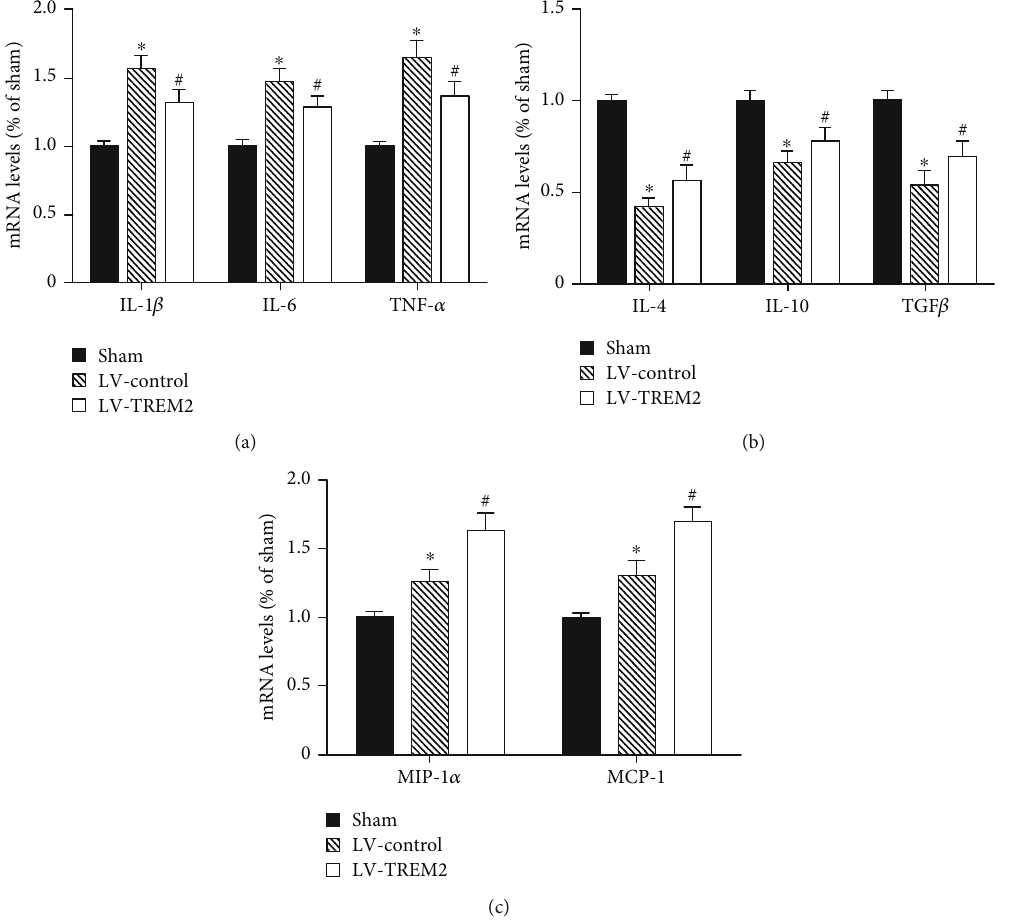
Figure 4: TREM2 overexpression attenuated in fl ammatory response in VD mice. (a) mRNA levels of proin fl ammatory mediators in the hippocampus of VD mice; (b) mRNA levels of anti-in fl ammatory mediators in the hippocampus of VD mice; (c) mRNA levels of chemokine cytokines in the hippocampus of VD mice. Compared to the sham group, ∗ p < 0 : 05 ; compared to the LV-control group, # p < 0 : 05